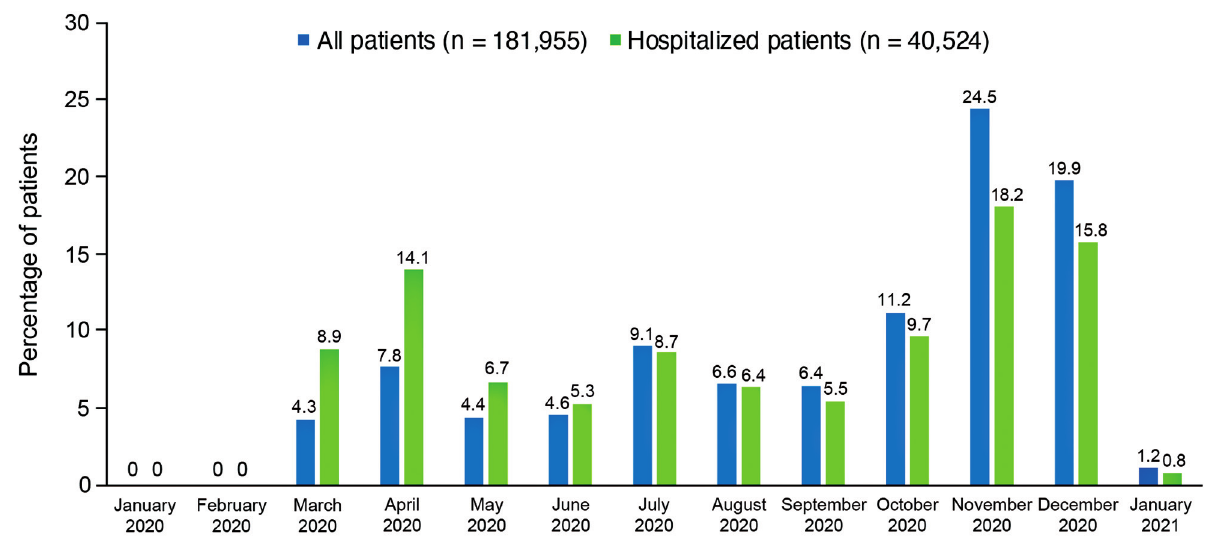
Fig. 2 Month of index COVID-19 diagnosis for all patients and hospitalized patients. COVID-19, coronavirus 2019.